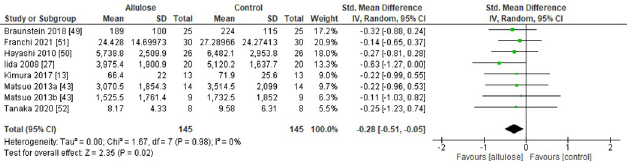
Fig 8. Forest plot of Random Effect Model for incremental AUC with a comparison between "Normal-Intakes ( < = 5g) and control".